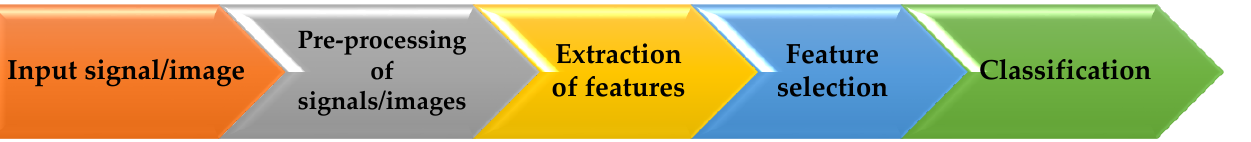
Figure 4. Sequence of steps for training a machine learning model.